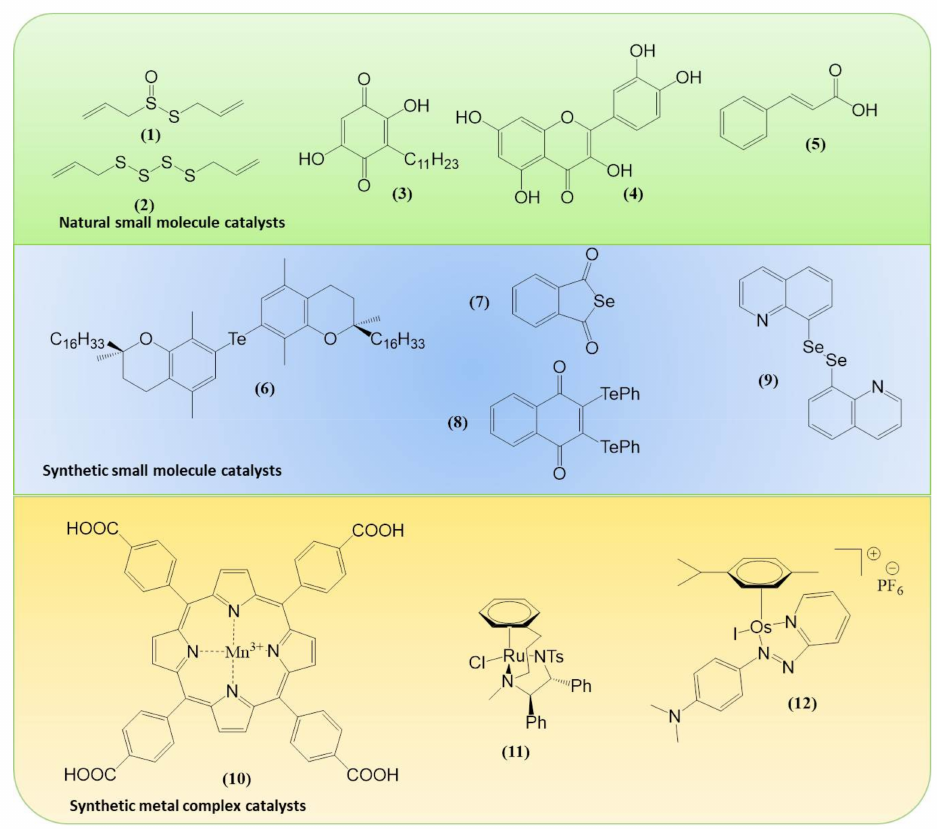
Figure 3. Chemical structures of the most important agents and catalysts discussed. allicin ( 1 ), diallyltetrasulfide (DATTS) ( 2 ), embelin ( 3 ), quercetin ( 4 ), cinnamic acid ( 5 ), 7,7 (cid:48) -tellurobis- ß -tocopherol ( 6 ), benzo[ c ]selenophene-1,3-dione ( 7 ), 2,3- bis (phenyltellanyl)naphthalene-1,4-dione ( 8 ), 1,2-di-(quinolin- 8-yl)diselane ( 9 ), Mn(III)tetrakis(4-benzoic acid)porphyrin ( 10 ), ( R , R )-[Ru( η 6 -C 6 H 5 (CH 2 ) 3 Ts DPEN- N -Me)Cl] ( 11 ) and [Os( η 6 - p -cymene)(4-(2-pyridylazo)- N , N- dimethylaniline)I]PF 6 ( 12 ).